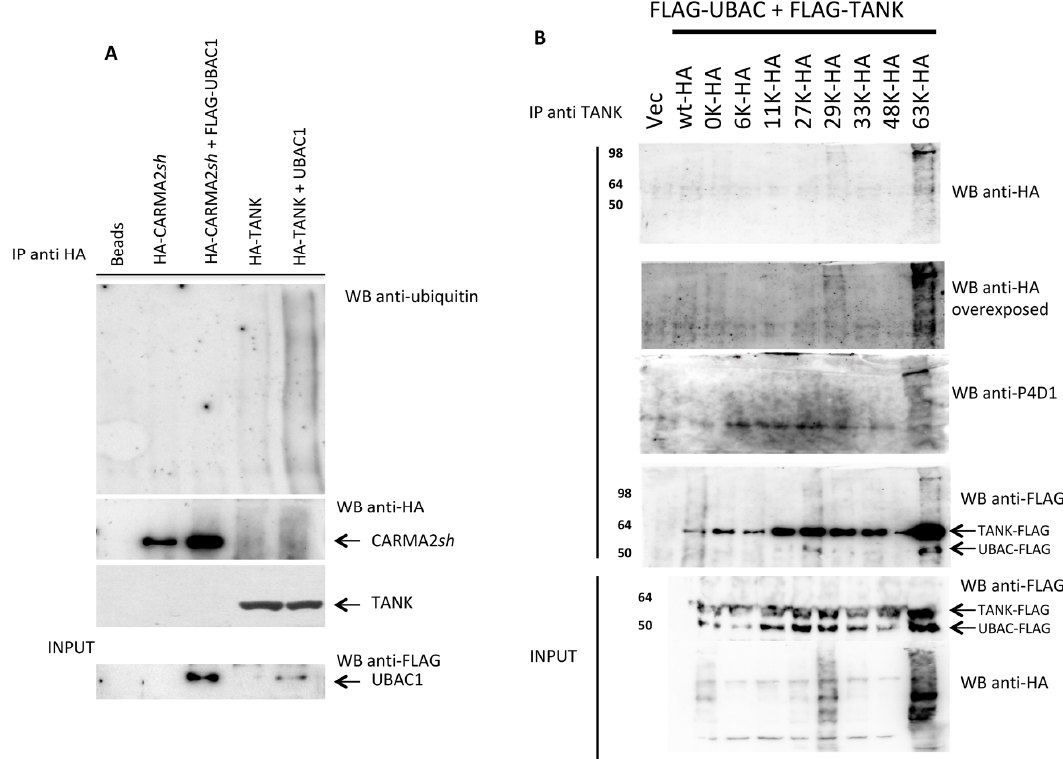
Figure 3. UBAC1 promotes K63-linked ubiquitination of TANK. ( A ) HEK293 cells were transfected with the indicated expression vectors. A total of 24 h later, cell lysates were immunoprecipitated with anti-HA antibody, separated by SDS-PAGE and transferred onto membranes subsequently probed with anti-ubiquitin. Statistical analysis for the blot shown in provided as supplementary Figure S1. ( B ) HEK293 cells were co-transfected with HA-tagged ubiquitin mutants and FLAG-tagged UBAC1 and TANK. The number indicates the only lysine residue remaining in the ubiquitin molecule. Immunoprecipitates with anti-TANK antibody were resolved by SDS-PAGE and blotted onto a membrane subsequently probed with anti-HA or anti- ubiquitin (P4D1). Statistical analysis for the blot shown in provided as supplementary Figure S1.